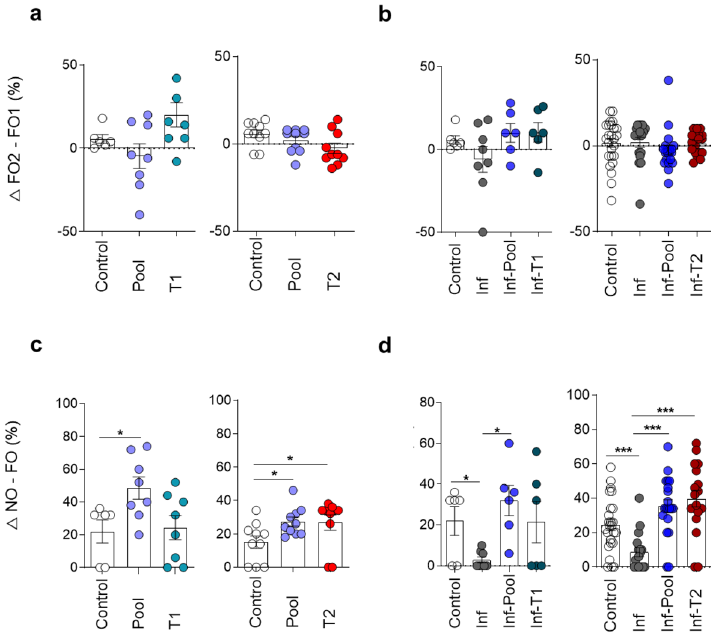
Figure 2. Immune stimulation enhances long-term memory performance in healthy and Pb A-infected mice. Healthy or Pb A-infected (and treated) mice were immune stimulated, or not, with the Pool, T1 or T2 strategies. Behavioural tasks were performed from day 88 to 92 post-infection (77 to 81 days after CQ treatment). Differences of time, in percentage of total time, spent on each object during the training ( a , b ) and test ( c , d ) sessions of the new object recognition task (NORT) in healthy ( a , c ) and infected ( b , d ) mice. FO familiar object; NO new object. Experimental groups: Control [non-infected/non-immune stimulated mice; n = 6, 10 and 25 (representative of different experiment); Pool (non-infected/Pool-immune stimulated mice, n = 8–10 representative of different experiment); T1 (non-infected/T1-immune stimulated mice, n = 8); T2 (non- infected/T2-immune stimulated mice, n = 10); Inf (infected/non-immune stimulated mice, n = 6–17); Inf-Pool (infected/Pool-immune stimulated mice, n = 6—20); Inf-T1 (infected/T1-immune stimulated mice, n = 6); Inf-T2 (infected/T2-immune stimulated mice, n = 8—18). Data are expressed as mean and s.e.m. ***P < 0.001; **P < 0.01; *P < 0.05; One-Way ANOVA was used [C, F (2,19) = 4.370 and F (2,27) = 3.416; D, F (3,22) = 3.705